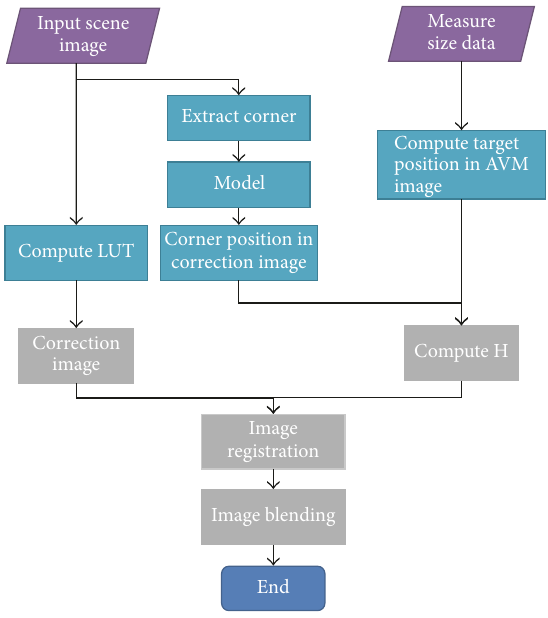
Figure 1: Flow chart of image